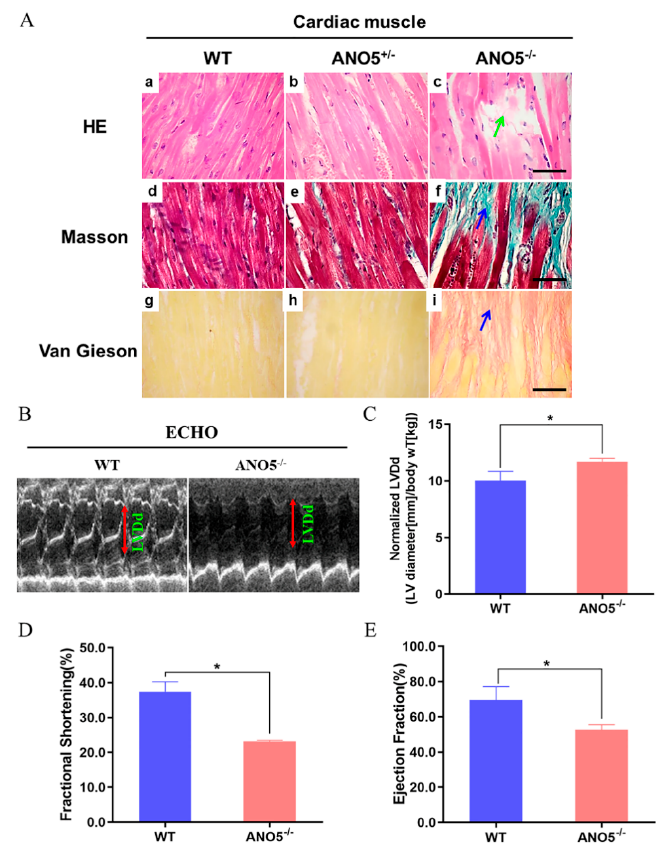
Figure 1. ( A ) H&E staining, Masson’ trichrome, and Van Gieson staining of cardiac muscles from wild-type (WT), ANO5 +/ − and ANO5 − / − rabbits. ( B ) Representative echocardiograms of ANO5 − / − and WT control. The red arrows represent the position of left ventricular end-diastolic diameter (LVDD). ( C ) The left ventricular diastolic diameter increased in ANO5 − / − rabbits. ( D ) The fractional shortening decreased in ANO5 − / − rabbits. ( E ) The left ventricular ejection fraction (EF) decreased in ANO5 − / − rabbits. The data is shown by means ± SEM and was analyzed by t -tests. * p < 0.05. Normalized LVDD, The ratio of LV diastolic diameter to body weight.